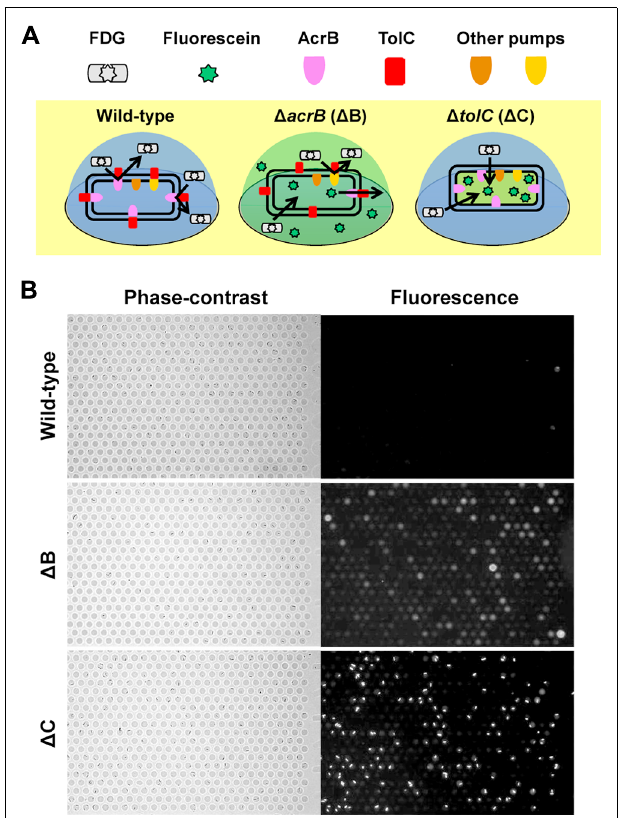
FIGURE 4 | Single-cell drug efflux assay. (A) Schematic of the principle of the single-cell drug efflux assay. (B) A representative assay. Phase-contrast (left) and fluorescence (right) images of the same field are shown.